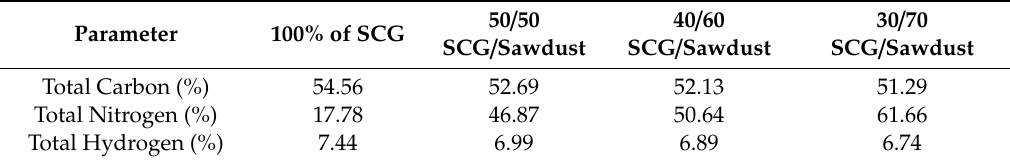
Table 1. Ultimate analysis of produced samples.